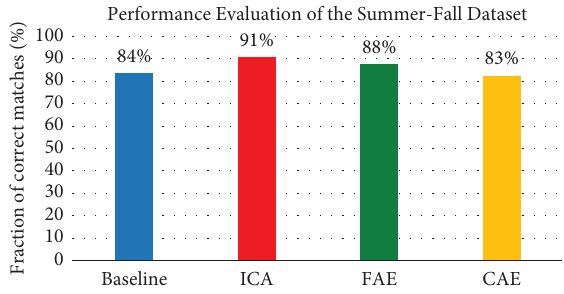
Figure 10: Fraction of correct baseline matches and proposed algorithms on the summer-fall dataset.